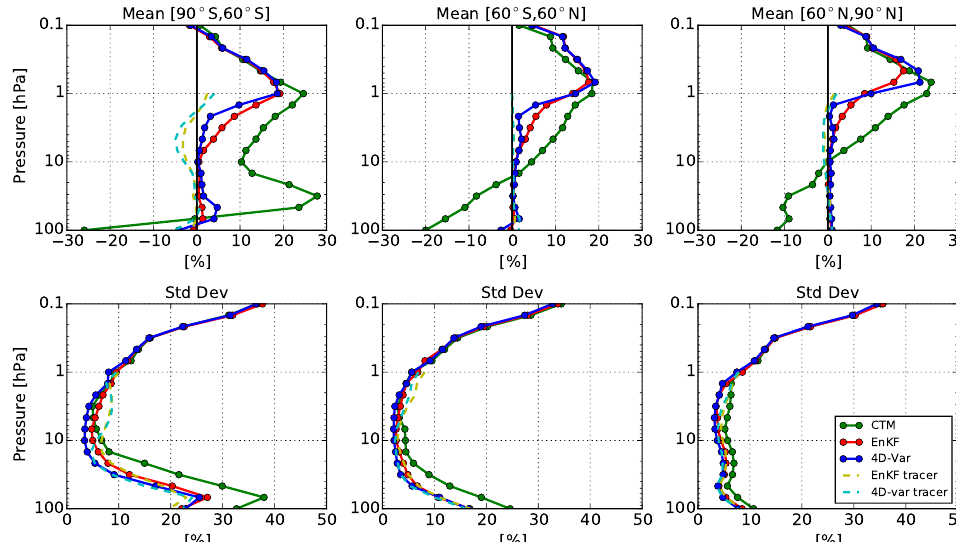
Figure 4. O 3 OmF bias (top) and standard deviation (bottom) computed for the full chemistry CTM (green), EnKF (red) and 4D-Var (blue) based on the same model. The chemical tracer EnKF (dashed yellow) and 4D-Var (cyan) are also shown. OmF statistics are computed in percent with respect to the assimilated EOS Aura-MLS data for the period September–October 2008 and for three latitude bands (from left to right: South Pole, tropics–middle latitudes and North Pole).